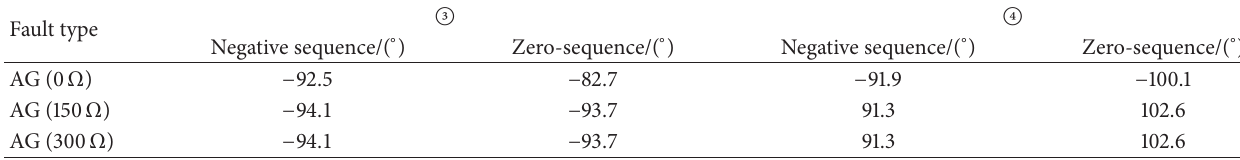
Table 1: The phase relationships of negative sequence and zero-sequence voltage and current when AG occurred at F4.